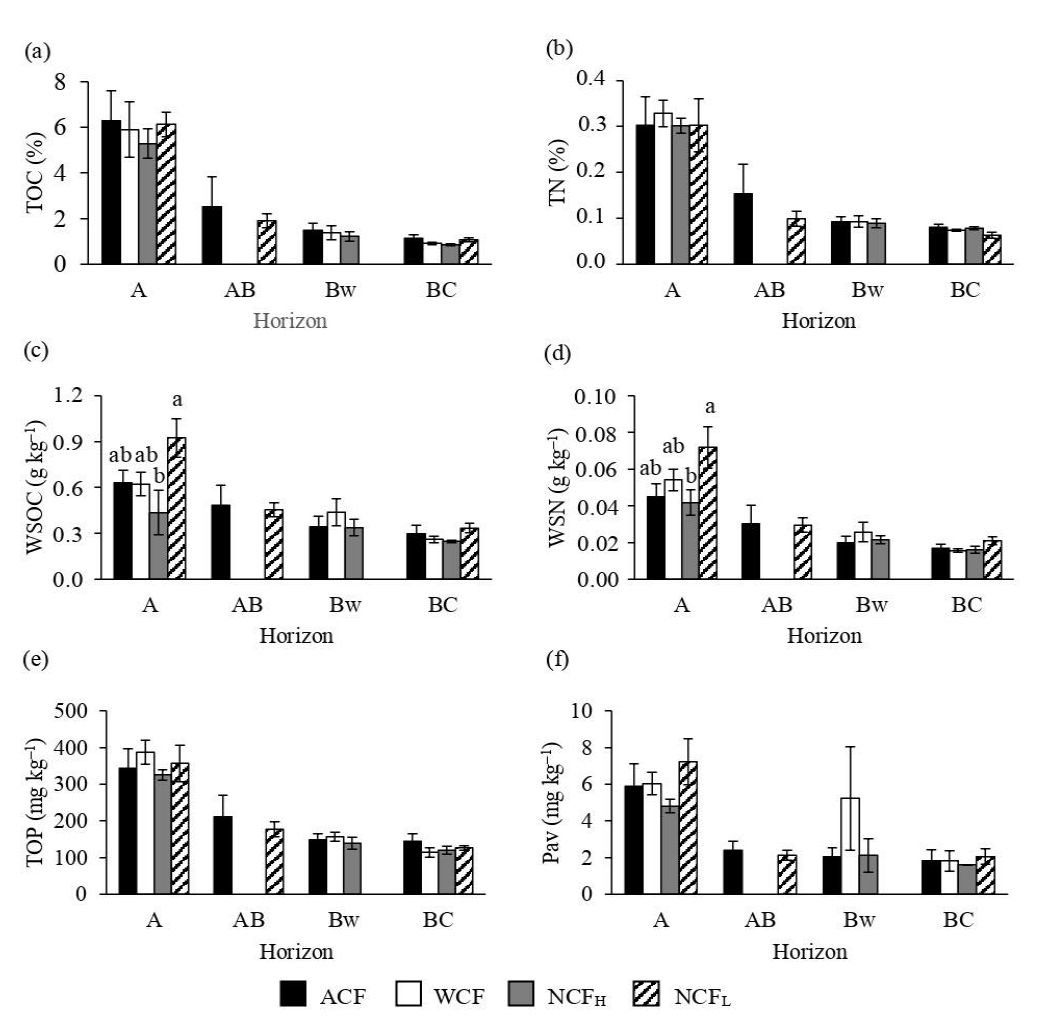
Figure 2. Concentrations of total organic carbon (TOC; a ), total nitrogen (TN; b ), water-soluble organic carbon (WSOC, c ), water-soluble nitrogen (WSN; d ), total organic phosphorus (TOP; e ) and available P (Pav; f ) of soils under an abandoned chestnut forest (ACF), a chestnut forest for wood production with a tree density of 151 plants ha − 1 (WCF), a chestnut forest for nut production with a tree density of 120 plants ha − 1 (NCF H ) and a chestnut forest for nut production with a tree density of 98 plants ha − 1 (NCF L ). Error bars are the standard errors. Within each horizon, di ff erent letters indicate significant di ff erences by Tukey’s t -test p ≤ 0.05.